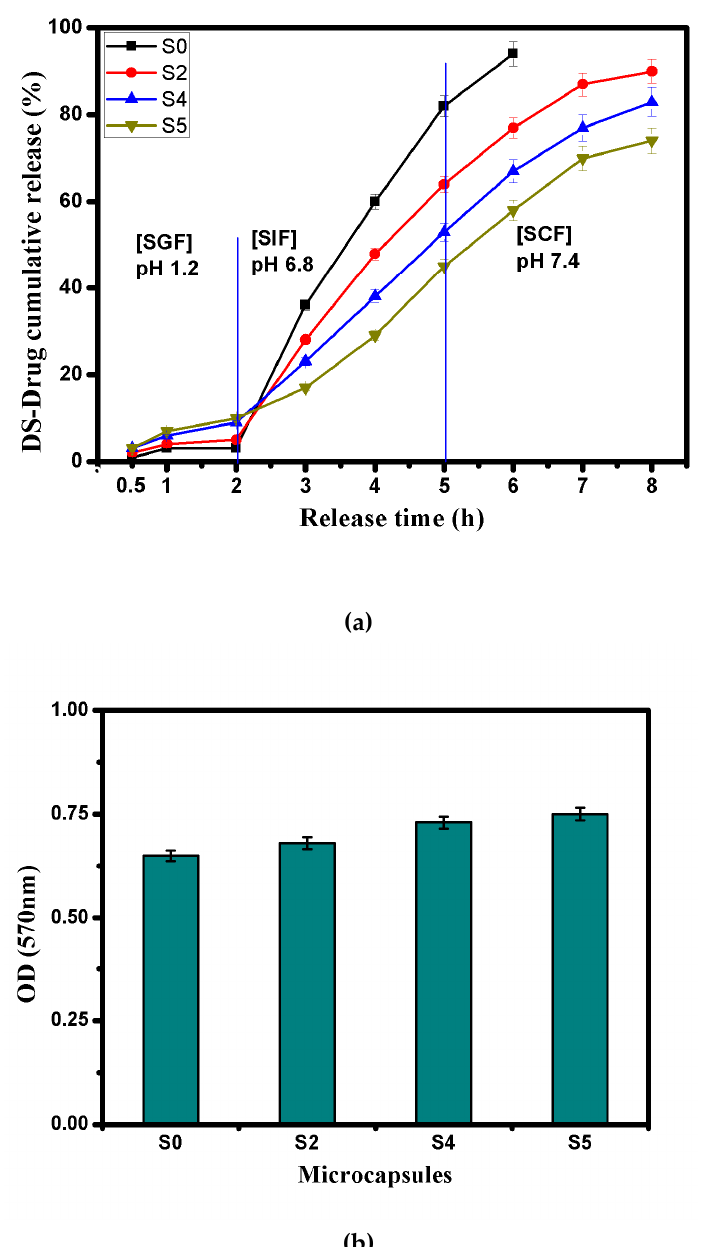
Figure 7. (a) Cumulative DS-drug release profiles at simulated GI-tract conditions and (b) Figure 7. ( a ) Cumulative DS-drug release profiles at simulated GI-tract conditions and ( b ) biodegra- biodegradation profiles for (S0) Alg, (S2) Alg-CMCs, and (S4 and S5) Alg-CMCs@AmCs dation profiles for (S0) Alg, (S2) Alg-CMCs, and (S4 and S5) Alg-CMCs@AmCs microcapsules. Values microcapsules. Values were presented as means ± S.D ( n = 3), and significant data were determined were presented as means ± S.D ( n = 3), and significant data were determined at p -value ≤ at p -value ≤ 0.05.